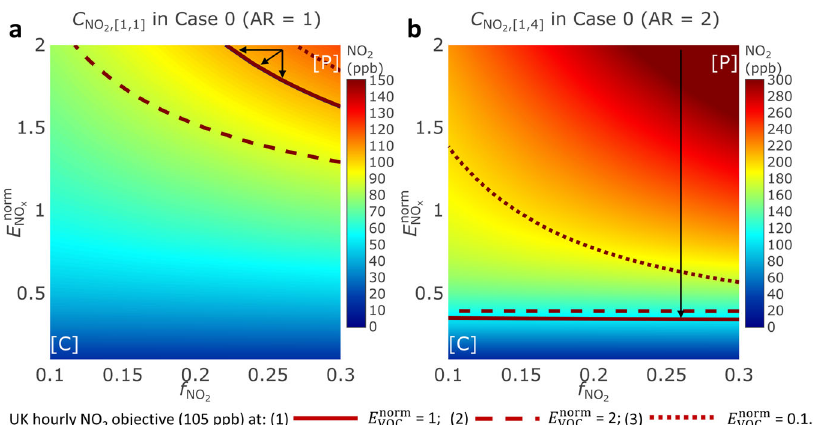
Fig. 1 Emissions effects on upward-vortex side NO 2 mixing-ratios at the pedestrian level in urban canyons. The upward-vortex side NO 2 mixing-ratios (ppb) at the pedestrian level of the regular ( a ) and deep ( b ) canyons at E norm fraction, E norm and E norm are the ratios of NO x and VOC emission rates to their typical emission condition (TEC), respectively. All simulated NO x VOCs patterns change when E VOCs is changed, and the compliance line shifts to the dotted and dashed lines when E norm respectively. The regions “ [P] ” and “ [C] ” divided by the compliance line represent the polluted and clean air zone, respectively. The arrows represent control strategies for NO 2 reduction under an intense emission condition (IEC), see text for